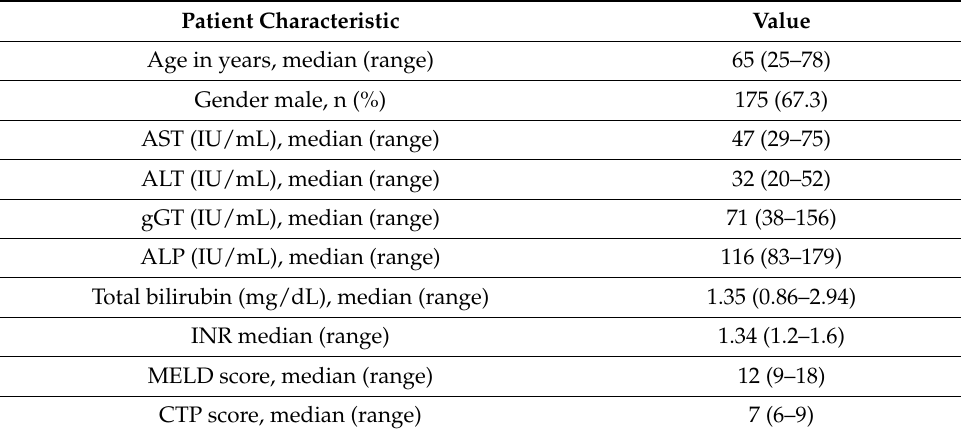
Table 1. Baseline characteristics of the study